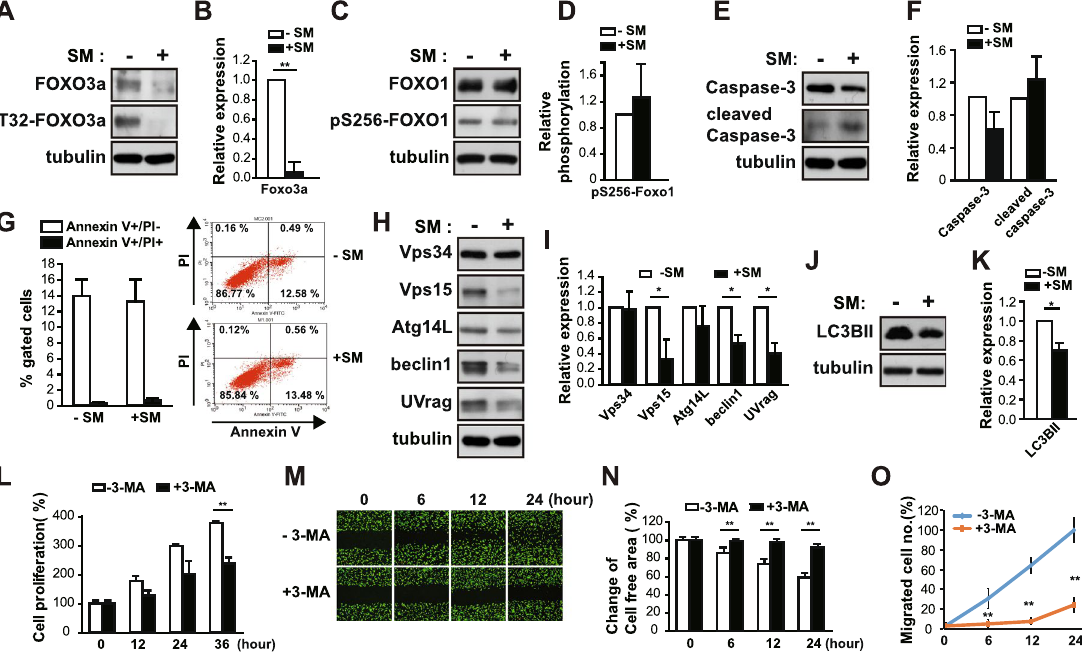
Figure 5. FOXO3a expression and autophagic flux decreased under SM condition in human eSCs. ( A – F,H – K ) Human eSCs were incubated either under terrestrial gravity (1 g ) or under SM for 36 h, lysed, and subjected to western blotting. ( B,D,F,I,K ) ImageJ was used to analyze the following: the expression level of FOXO3a relative to tubulin ( B ), the phosphorylation of pS256-FOXO1 relative to FOXO1 ( D ), the expression level of caspase-3 and cleaved caspase-3 relative to tubulin ( F ), the expression level of Vps34, Vps15, Atg14L, beclin1, and UVrag relative to tubulin ( I ), and the expression of LC3BII relative to tubulin ( K ). ( G ) Cells were treated as in (A), stained with PI and annexin V, and analyzed by flow cytometry. ( L ) Cells were incubated with or without 10 mM 3-MA for the indicated times and counted using cell counter. ( M – O ) The cells were scratched with a T200 tip and then treated as in ( L ) for the indicated times. ( M ) Cells were stained using the CytoPainter Cell Tracking Staining Kit and photographed. ( N ) The cell-free area was measured using ImageJ and change of cell- free area was calculated. ( O ) The number of migrated cells was counted using ImageJ. Abbreviations: simulated microgravity (SM); propidium iodine (PI); 3-methyladenine (3-MA). Data are expressed as mean ± SD, with paired t -tests performed as indicated. * P < 0.05, ** P < 0.01 versus control at each indicated